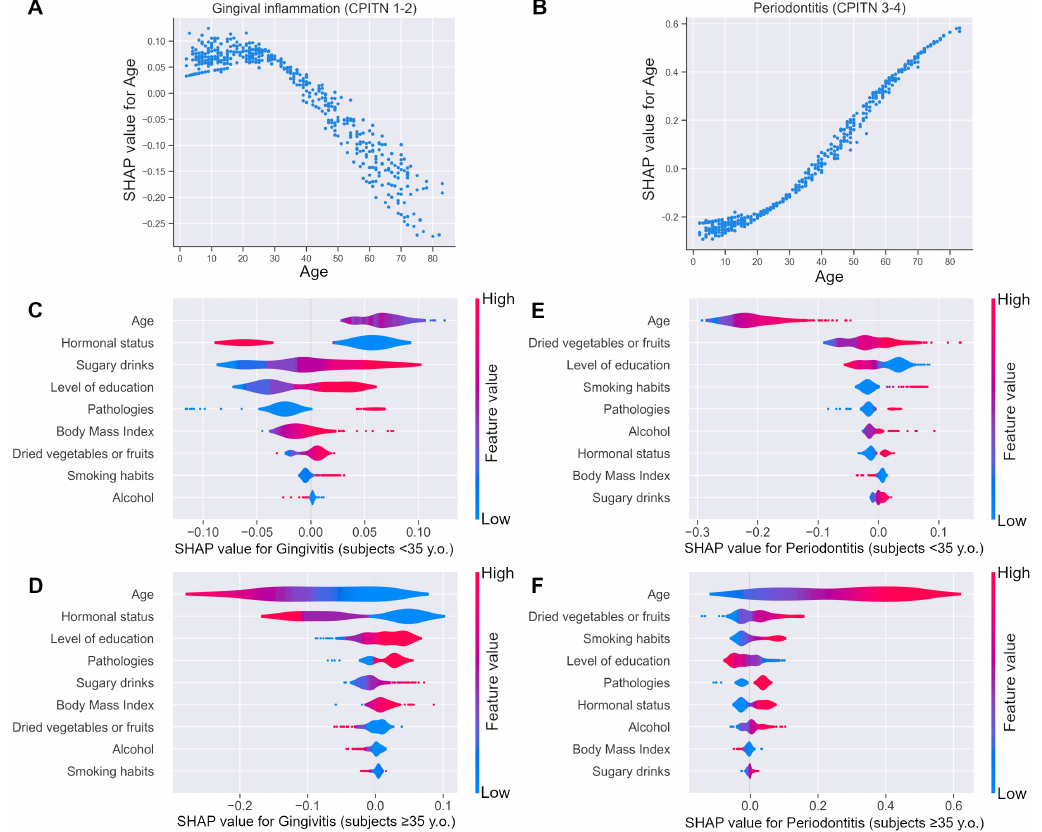
Figure 5. SHAP contribution for CPITN prediction according to the pivotal age of 35 years. ( A , B ) The partial dependence plots show how the SHAP values partially depend on the input variables of inter- est. ( A ) Rise of gingival inflammation risk until 35 years old and decrease thereafter. ( B ) Sigmoid-type relationship of periodontitis risk with age with a sharp transition around 35 years old. ( C – F ) SHAP values of gingival inflammation ( C , D ) or periodontitis ( E , F ) risk according to feature values for subjects < 35 years old ( C , E ), and subjects > 35 years old ( D , F ). The color of each violin plot encodes the value of the associated variable, red for higher values of the variable and blue for lower values. For the categorical variables, a low value can also signify a missing value. For hormonal status, the values are in increasing order as follows: being a man or a girl (<12 years old), non-menopausal woman, postmenopausal woman. On the x–axis, a positive SHAP value signifies that the variable contributes positively to the risk prediction, whereas a negative SHAP value signifies that the variable negatively contributes to the prediction. Variables are shown from the top to the bottom in order of importance (mean of absolute SHAP